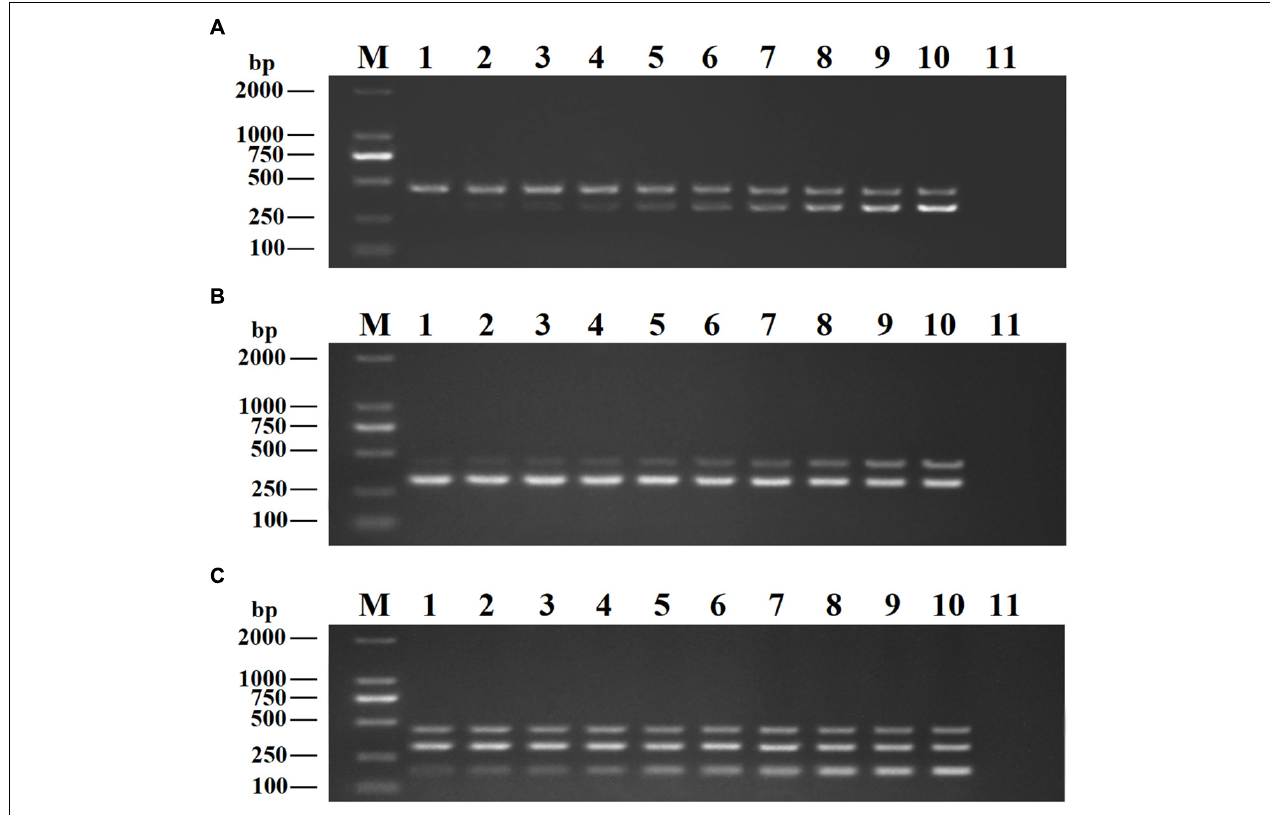
FIGURE 3 | Optimization of primer concentrations. The recombinant plasmids (pMD19-T-VP6, pMD19-T-VP2, and pMD19-T-5 (cid:48) UTR) were used as templates. (A) When the volumes of BRV-DPOF (10 µ M) and BRV-DPOR (10 µ M) were 1.0 µ L, the volumes of BPV-DPOF (10 µ M), and BPV-DPOR (10 µ M) were tested ranging from 0.1 to 1.0 µ L in increments of 0.1 µ L. (B) When the volumes of BPV-DPOF (10 µ M) and BPV-DPOR (10 µ M) were 1.0 µ L, the volumes of BRV-DPOF (10 µ M), and BRV-DPOR (10 µ M) were tested ranging from 0.1 to 1.0 µ L in increments of 0.1 µ L. (C) When the volumes of BRV-DPOF (10 µ M), BRV-DPOR (10 µ M), BPV-DPOF (10 µ M), and BPV-DPOR (10 µ M) were all 1.0 µ L, the volumes of BVDV-DPOF (10 µ M) and BVDV-DPOR (10 µ M) were tested ranging from 0.1 to 1.0 µ L in increments of 0.1 µ L. Lane M, DL2000 DNA maker; Lane 1–10, 0.1 µ L, 0.2 µ L, 0.3 µ L, 0.4 µ L, 0.5 µ L, 0.6 µ L, 0.7 µ L, 0.8 µ L, 0.9 µ L and 1.0 µ L, respectively; Lane 11, negative